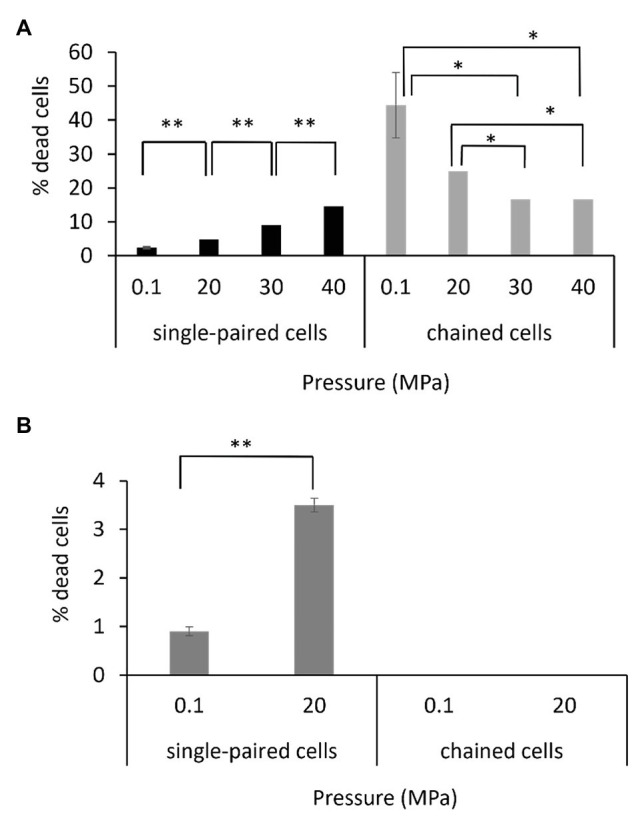
Viabilities of single-paired cells and chained cells of P. elfii DSM9442 (A) and P. elfii subsp. lettingae
(B) collected during the exponential phase at various hydrostatic pressures, expressed as percentages of dead cells within each morphotype. One asterisk (*) indicates a significant difference between samples with p < 0.01 (z-test, α = 0.01) and two asterisks (**) indicate p < 0.001 (z-test, α = 0.01).